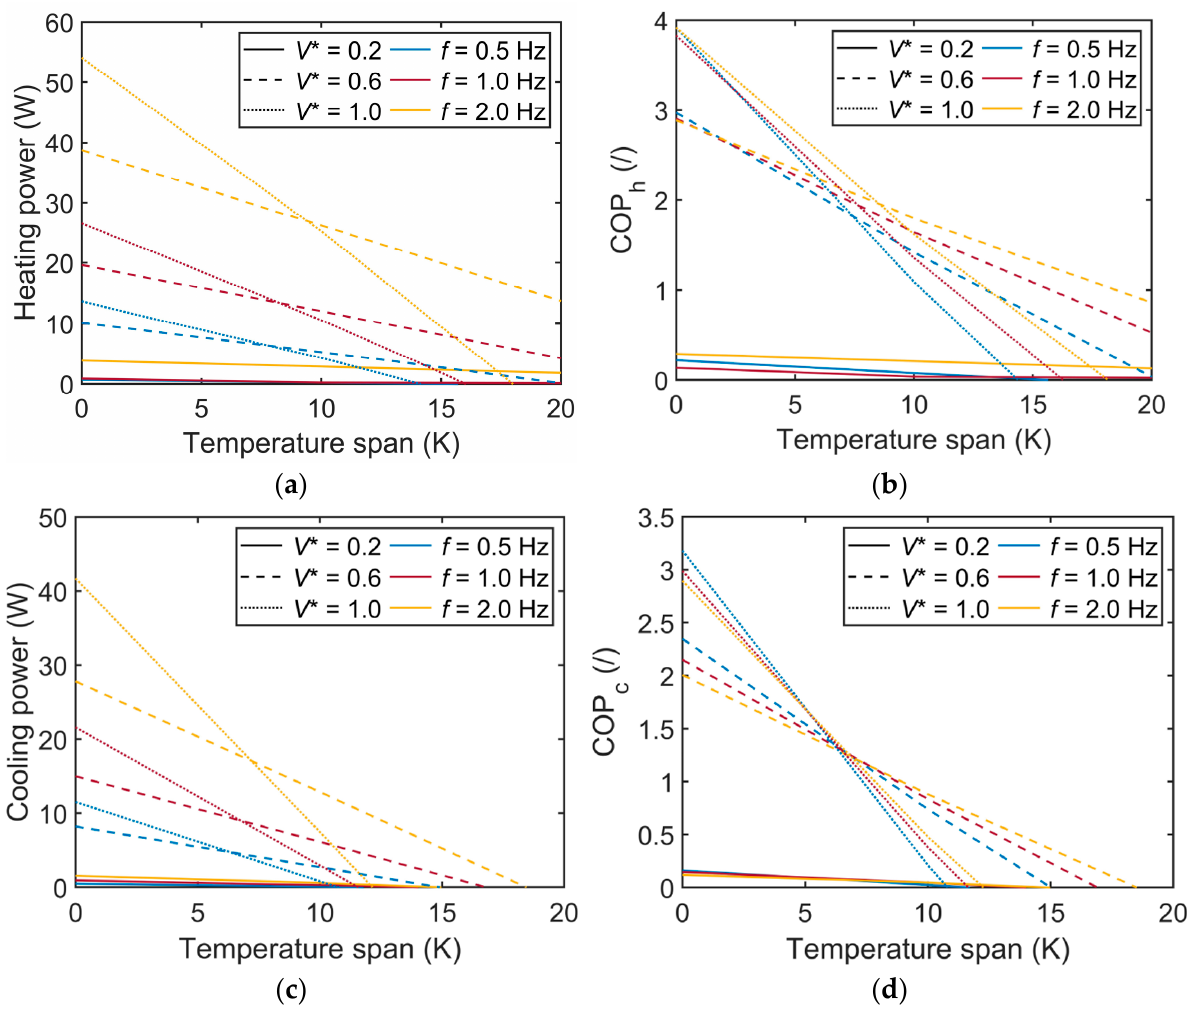
Figure 11. The effect of temperature span on AeCR performance at a fixed strain of 2.7% for heat- pumping ( a , b ) and cooling ( c , d ).